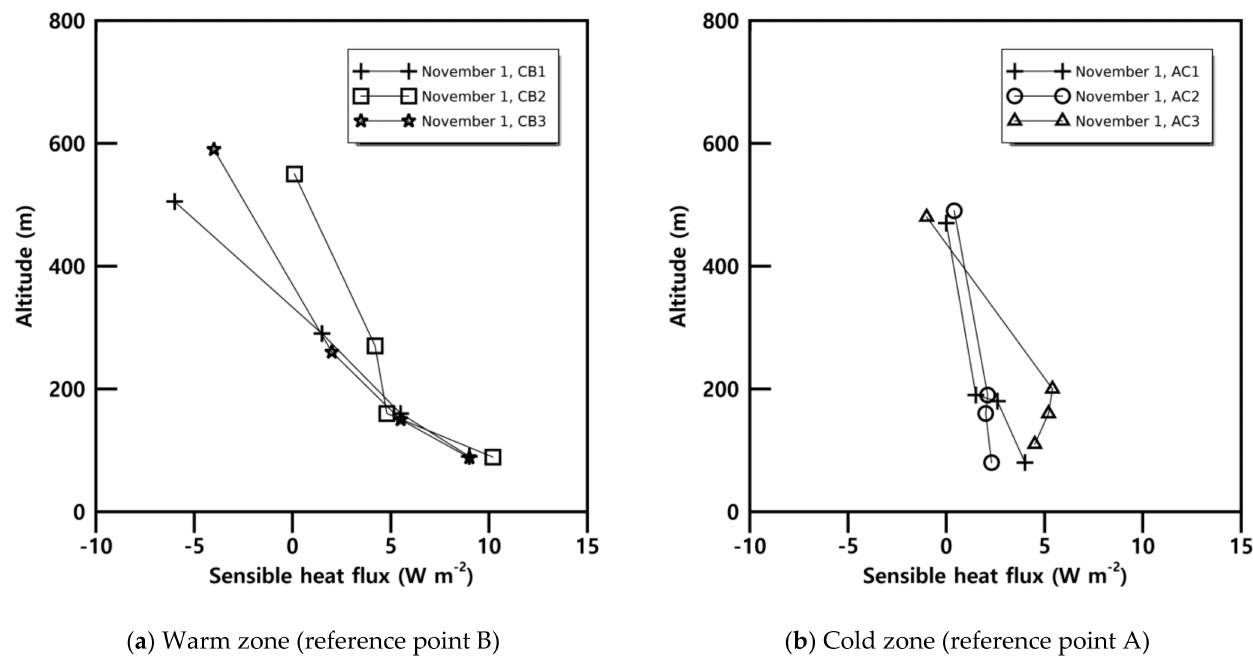
Figure 9. Vertical variations of the sensible heat flux at ( a ) warm zone and ( b ) cold zone for six segments on November